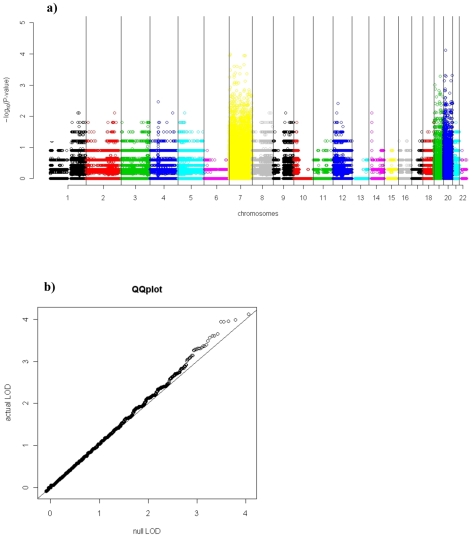
Genome wide ADT analysis of 178 TCGA glioblastoma samples.Manhattan-style plot (A) of amplification distortion P-value (y-axis, log10 scale) along the genome (x-axis). Save for the strongest hits, the ADT statistic follows the distribution expected under the null hypothesis, as demonstrated by the quantile-quantile plot (B) of P-values (log10 scale). Only SNPs with nine or more amplified heterozygous samples are presented, to avoid effects of discrete probabilities in a small sample.